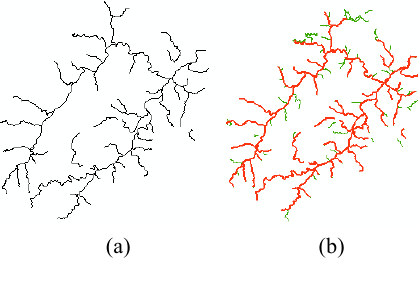
Figure 4: The original maps of different scales